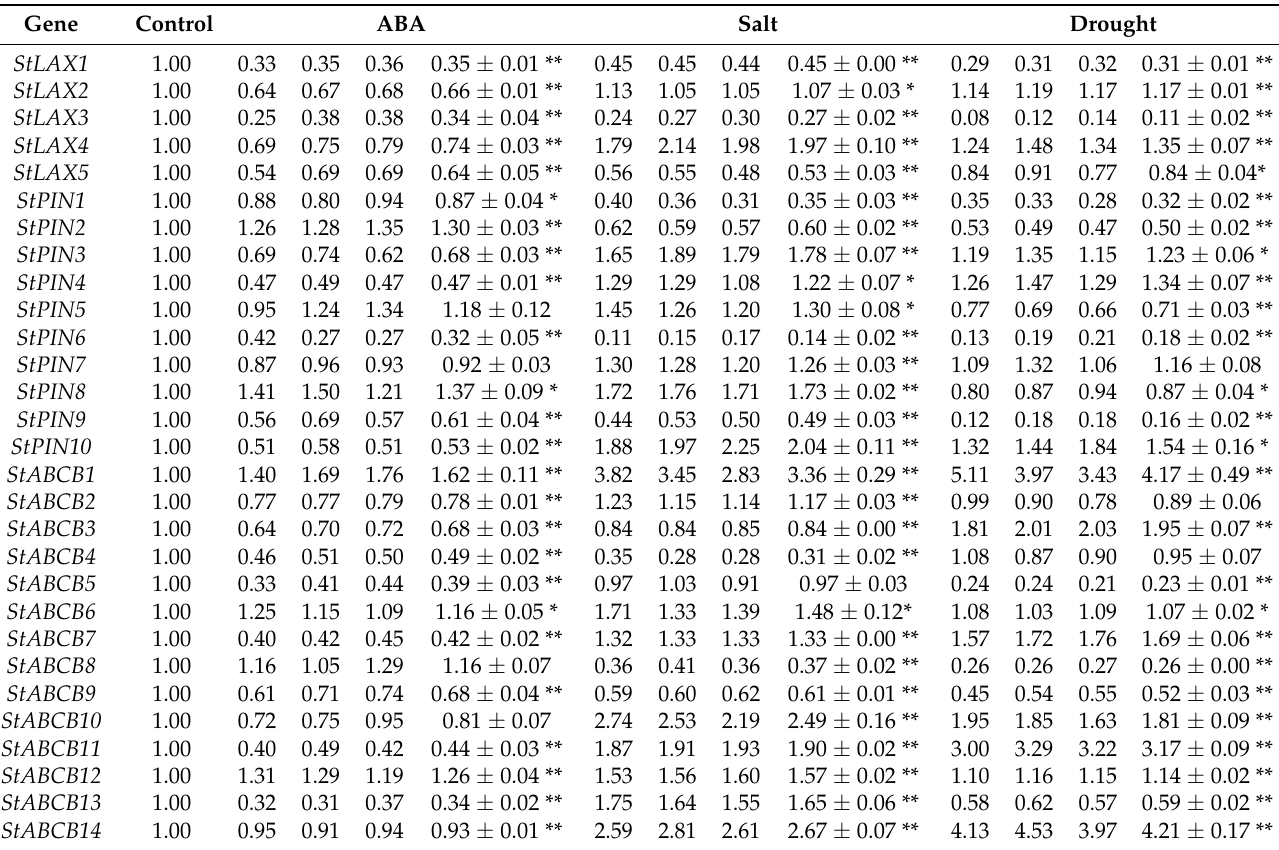
Table A9. Raw data of auxin transporter genes under ABA and abiotic